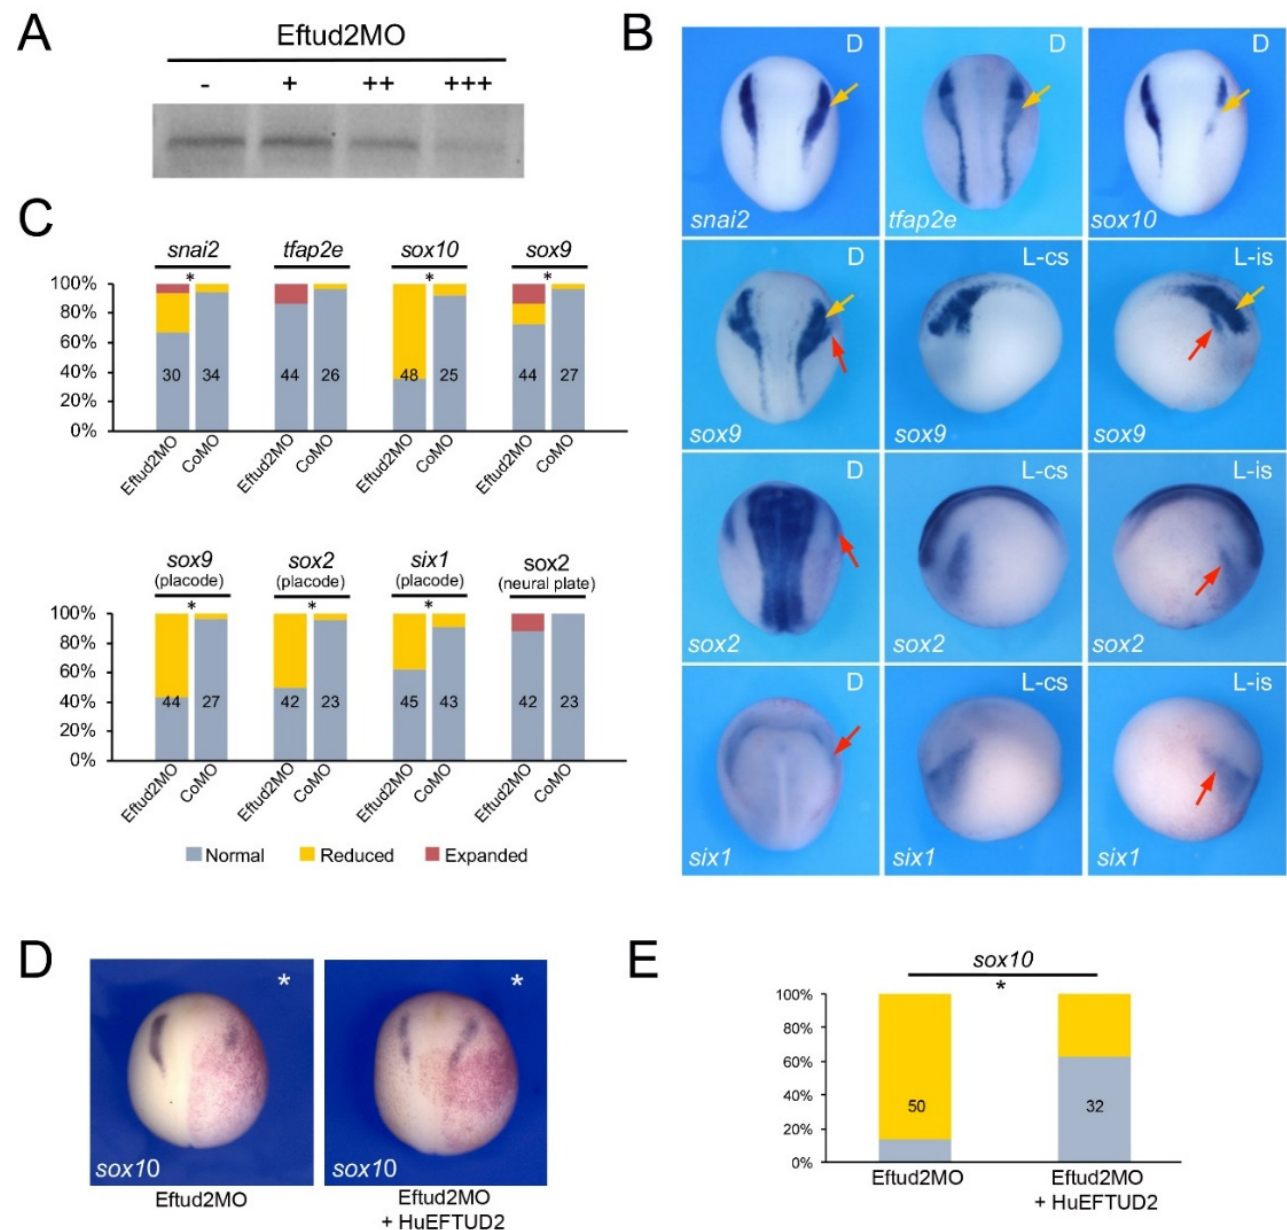
Figure 2. Eftud2 knockdown affects neural crest formation. ( A ) Increasing amounts of Eftud2MO, 10 ng (+), 100 ng (++) and 500 ng (+++), block translation directed by eftud2 mRNA. (-) Translation without Eftud2MO ( B ) Phenotype of Eftud2MO-injected embryos (30 ng) on neural crest (yellow arrows) and placode (red arrows) gene expression at stage 15. The gene analyzed in each panel is indicated in the lower left corner. D indicates dorsal view, anterior to top. L-cs indicates lateral view control side, anterior to left. L-is indicates lateral view injected side, anterior to right. ( C ) Quantification of the phenotypes. The numbers in each bar indicate the number of embryos analyzed. ( D ) sox10 expression in Eftud2MO-injected embryos is partially restored by expression of HuEFTUD2 resistant to the MO. The injected side is indicated by an asterisk. Dorsal views, anterior to top. ( E ) Quantification of the results. The numbers in each bar indicate the number of embryos analyzed. Statistically significant differences are indicated (*) p- value < 0.05 (Chi-squared test).